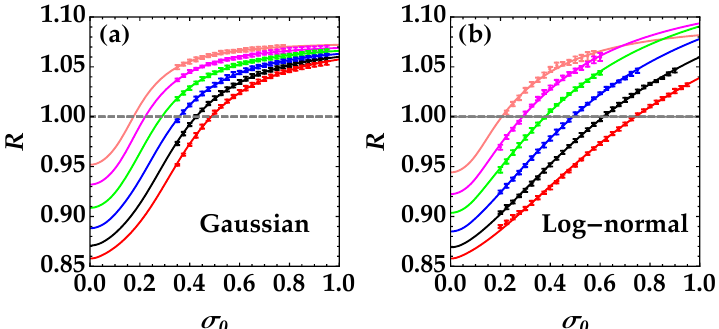
Figure 5. Noise reduction factor as a function of the standard deviation σ 0 of the Gaussian (panel ( a )) and log-normal (panel ( b )) distributions defined over the entire domain for different values of t 0 . The experimental data are shown as colored dots + error bars: pink dots refer to t 0 = 0.4, magenta dots to t 0 = 0.5, green dots to t 0 = 0.6, blue dots to t 0 = 0.7, black dots to t 0 = 0.8, and red dots to t 0 = 0.9. The corresponding theoretical fitting functions are plotted as colored curves with the same color choice. In the fitting procedure we fixed (cid:104) m (cid:105) = 2.23 and η = 0.145 and we left t 0,FIT and m µ as fitting parameters. The values of such parameters are reported in Tables 1 and 2 together with the χ 2 per degree of freedom.